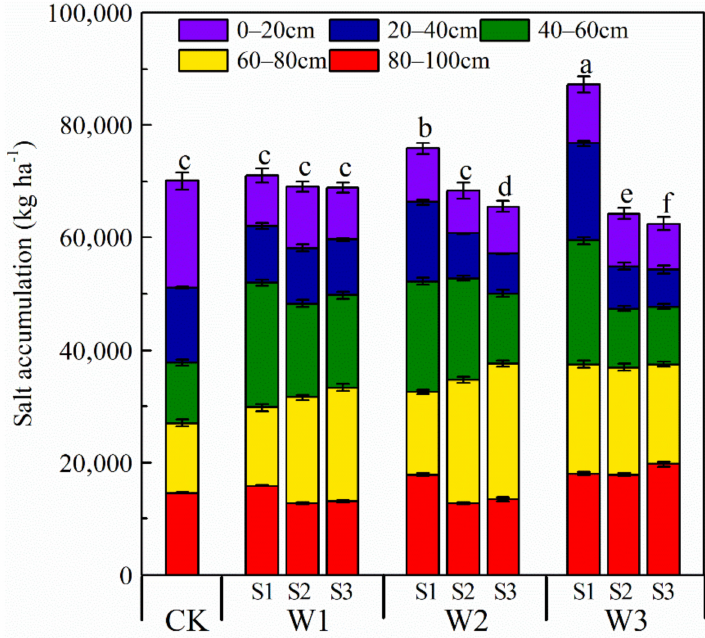
Figure 5. Salt accumulation in 0–100 cm soil profile at harvest